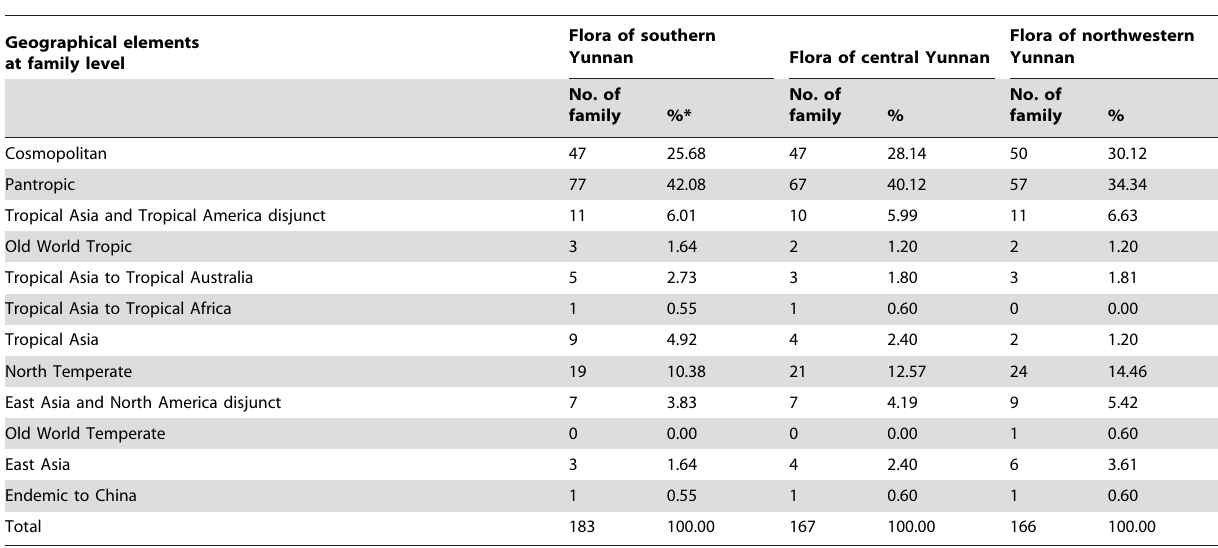
Table 3. Geographical elements of seed plants at the family level of these three compared floras.